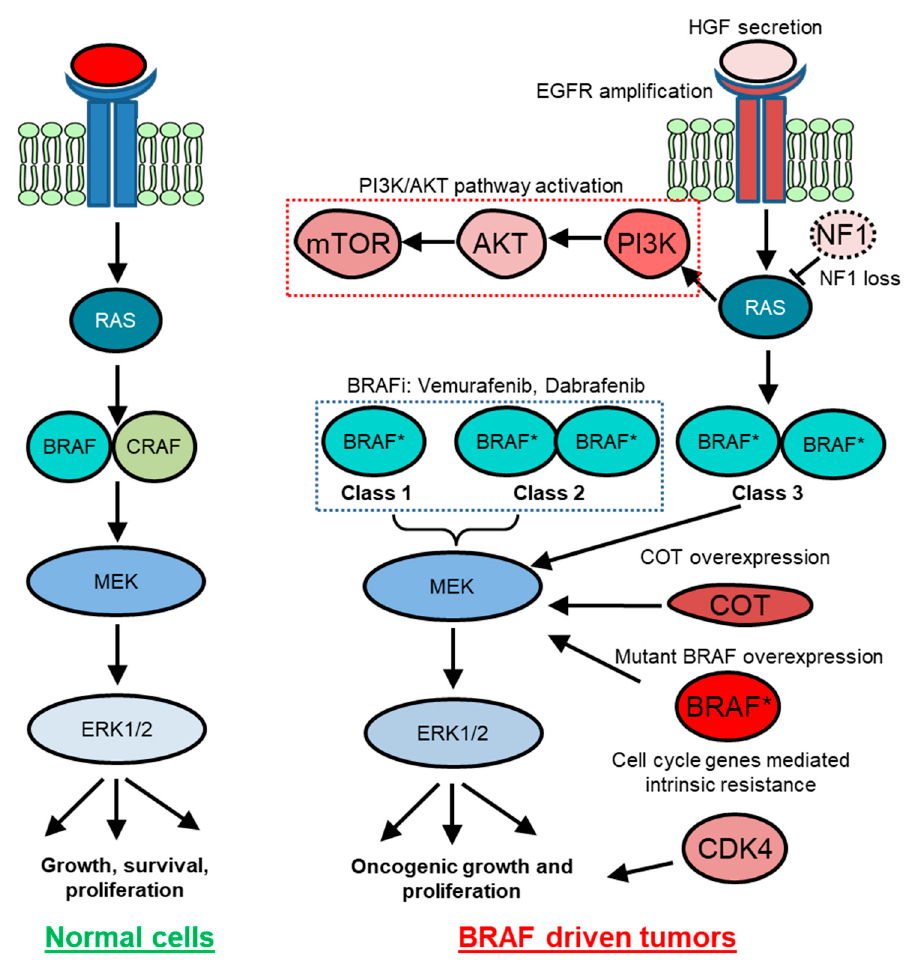
Figure 3. BRAF-mediated signaling in normal and cancer cells. In normal cells, external growth stimuli activate receptor tyrosine kinase (RTK) and RAS, which relays growth signals to the mitogen-activated protein kinase (MAPK) pathway kinase cascade. In BRAF-driven cancers, mutant BRAF (BRAF *) can either act RAS independently as a monomer (Class 1) and as a dimer (Class 2) or act RAS dependently (Class 3) to hyperactivate cellular growth. Class 1 and Class 2 tumors respond to BRAF inhibitor-targeted therapy. However, various intrinsic or adaptive resistance mechanisms attenuate response to targeted BRAF inactivation. For example, preexisting NF1 loss, CDK4 mutations, and increased COT and YAP expression may specify intrinsic resistance. Therapy-induced HGF secretion and PI3K-AKT pathway activation are examples of some of the adaptive resistance mechanisms. On the other hand, EGFR-amplified population gives rise to acquired resistance to BRAF inhibitors.